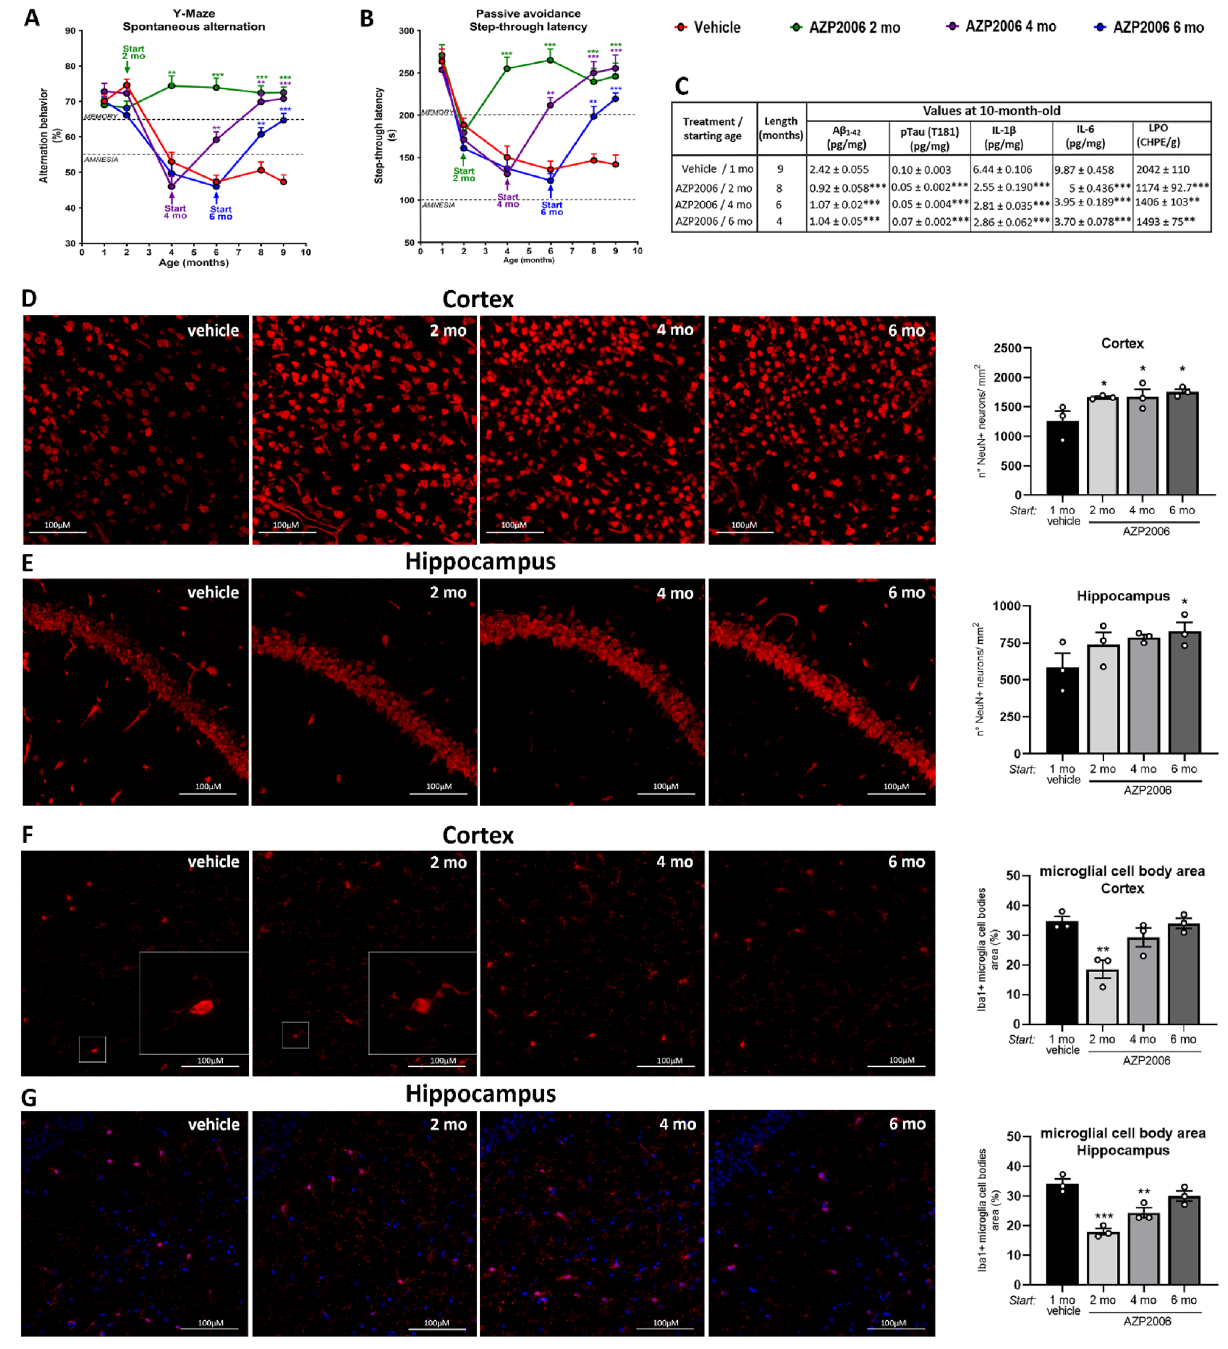
Figure 5. AZP2006 significantly improved senescence behavior and markers in SAMP8 mice. (A , B) Age-associated behavioral impairments including learning and memory difficulties were measured by Y-maze and Step-Through Passive Avoidance test. Animals received a dose of AZP2006 at 3 mg/kg/day in drinking water for 8, 6 or 4 months or water alone as control (vehicle). The percentage of spontaneous alternation in the Y-Maze was used to measure the exploration of a new environment and Step-Through Passive Avoidance test was used to evaluate recognition memory. ( C ) Aβ 1-42 and pTau(T181) level (AD markers), cytokines levels (sign of inflammation) and LPO level (oxidative stress) markers normally triggered by aging were reduced upon AZP2006 treatment. The table reports the ELISA quantification of pTau(T181) in hippocampus and Aβ 1-42 , IL-1β and IL-6 in cortex, and the measurement of LPO in hippocampus of 10-month-old SAMP8 mice. All values are expressed as mean ± SEM, n = 10–12/group. ** p < 0.01 and *** p < 0.001 versus vehicle. ( D , E ) Neuronal cells were identified by immunofluorescence staining with NeuN (red fluorescence) in cortex and hippocampus. Left , Representative images of the 4 experimental conditions are shown. Right, NeuN quantification was made on 3–9 slides. ( F , G) Left , Representative images of Iba1-positive microglia (red fluorescence) in cortex and hippocampus. White squares show a microglia magnification (see also Supplementary Fig. 6). Right , Iba1 quantification. One-way ANOVA followed by Fisher’s LSD test. * p < 0.05, ** p < 0.01 or *** p < 0.001 versus 1mo